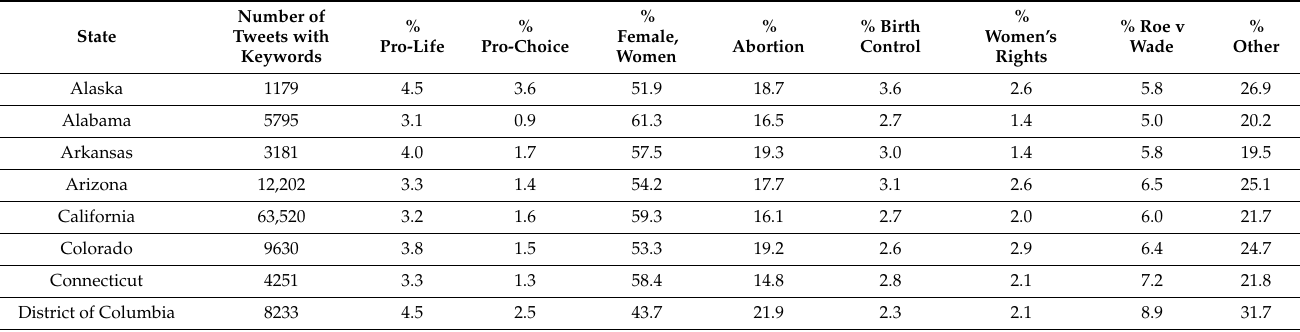
Table A4. Proportion of tweets in each topic category, by